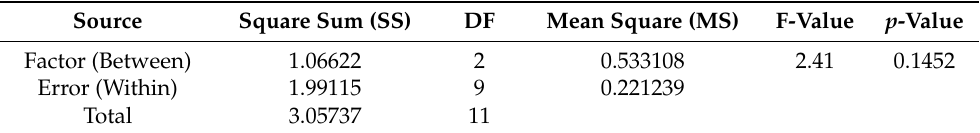
Table 15. Effect of P1 fiber type and temperature on f R,b by applying ANOVA analysis. Source Square Sum (SS) DF Mean Square (MS) Factor (Between) Error (Within)